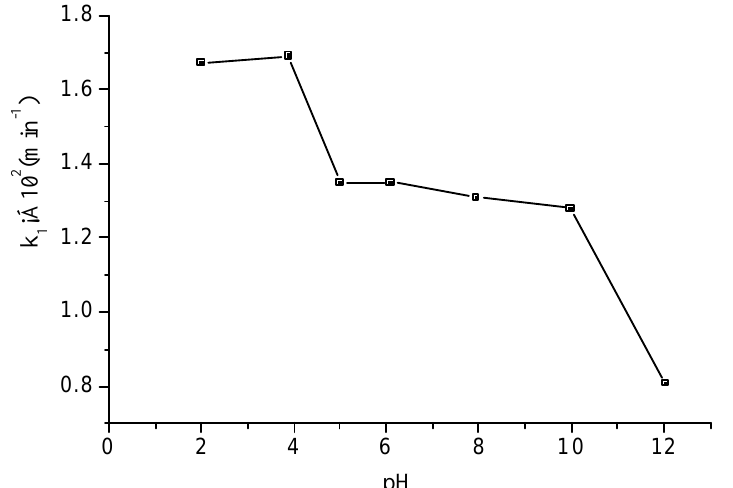
Figure 6. The influence of the acidity of reaction medium on the degradation of methyl